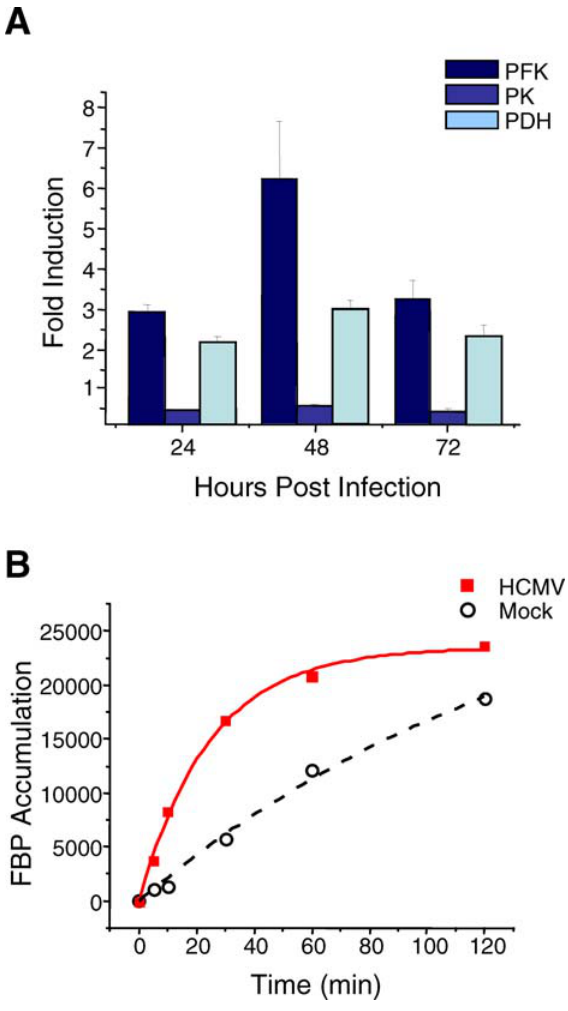
Figure 2. HCMV-Induced Changes in Metabolic Enzyme Activity and Transcript Levels (A) Levels of metabolic mRNA transcripts during HCMV infection. Transcript levels for phosphofructokinase-1(PFK), pyruvate kinase (PK), and pyruvate dehydrogenase (PDH) were assayed at 24, 48, and 72 h post-mock or post-HCMV infection by qPCR. Bars represent the mean levels ( n ¼ 2) in the HCMV-infected cells divided by those in the mock- infected cells at the indicated time point, with the error bars showing þ 1 SD of the mean. (B) HCMV induction of phosphofructokinase activity. FBP accumulation was measured in mock-infected (dotted line) and HCMV-infected (red line) cellular lysates collected at 48 hpi. Similar results were found in three independent experiments.